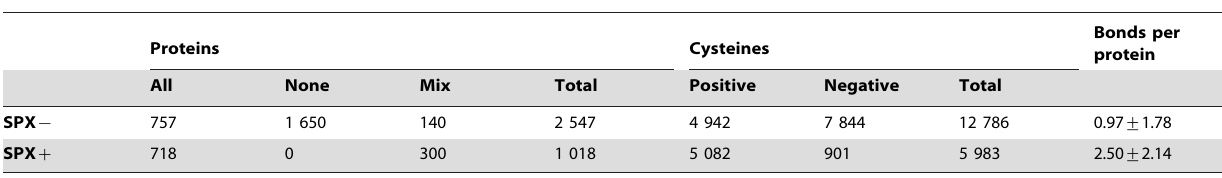
Table 1. Dataset statistics.